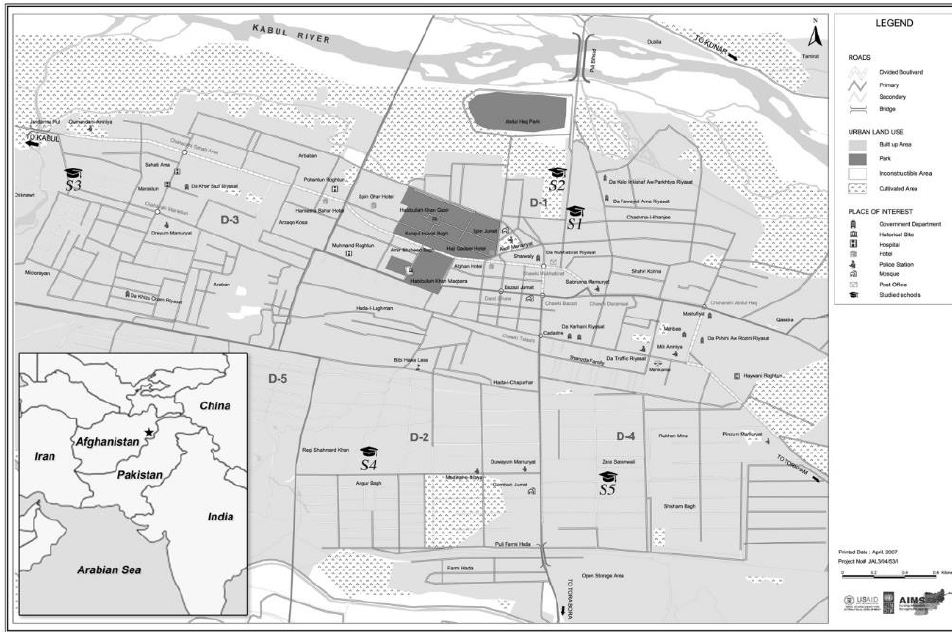
Figure 1. Map of Jalalabad and the studied schools with main roads.